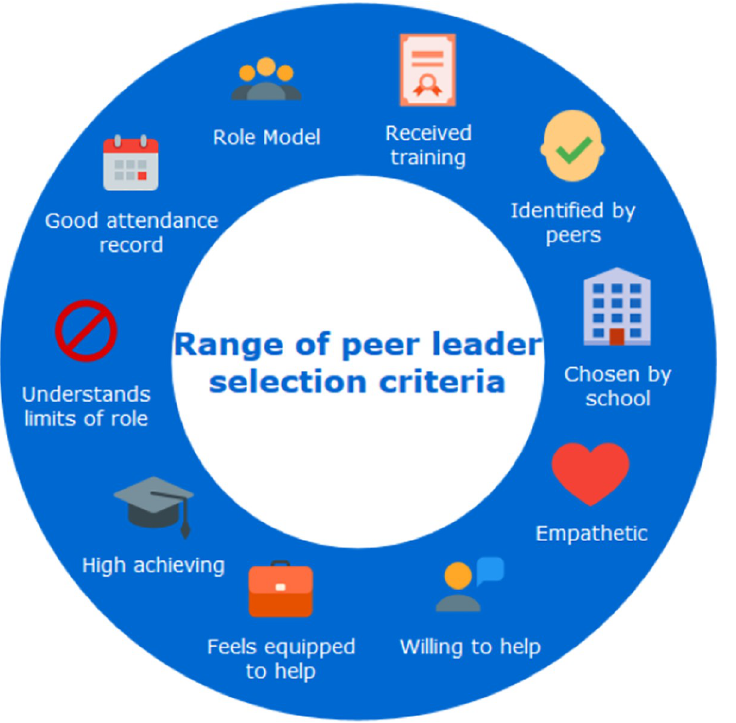
Fig 3. Range of peer leader selection criteria seen across included